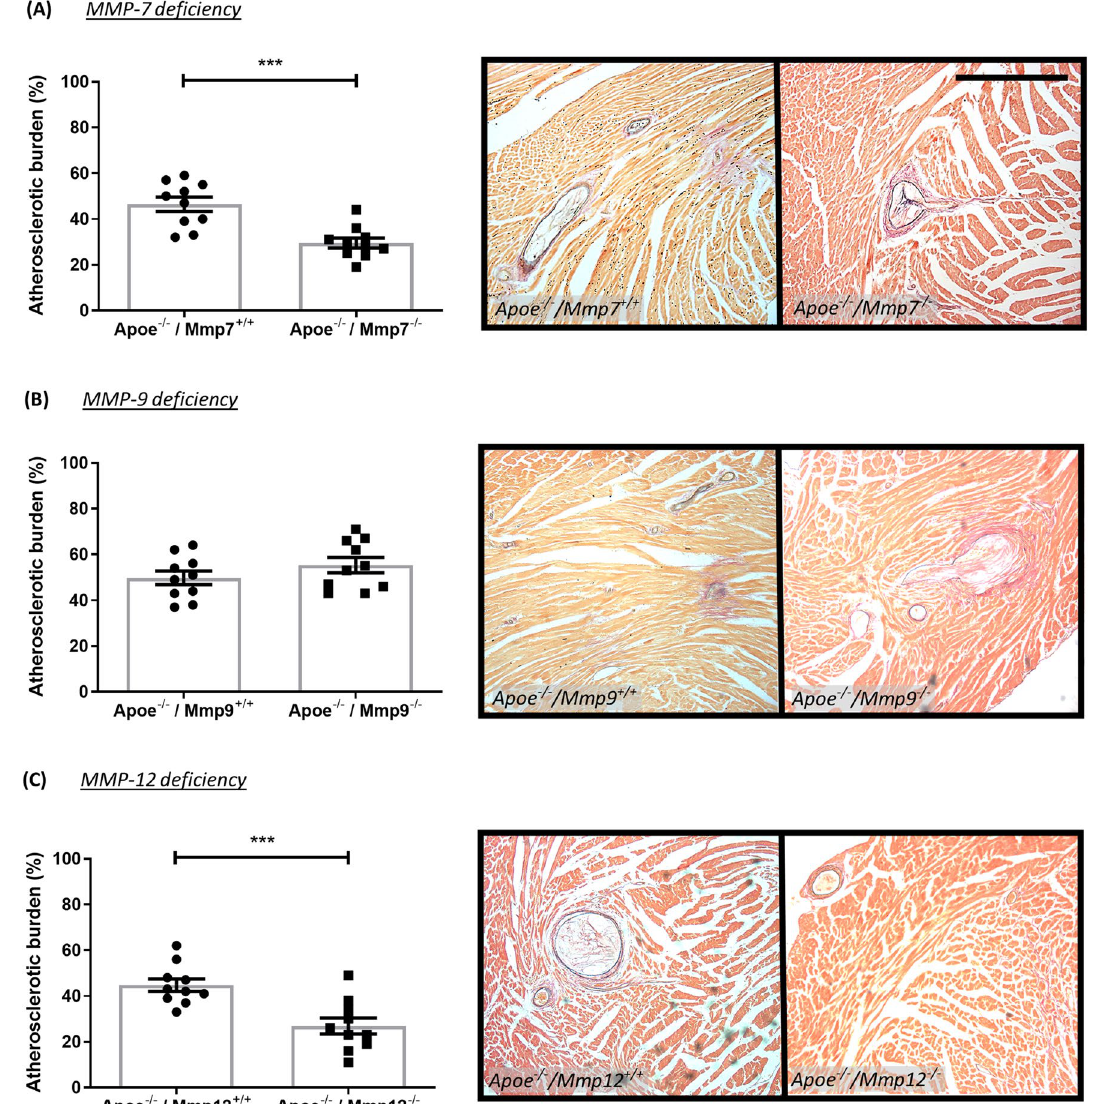
Figure 3. Effect of MMP modulation on coronary artery atherosclerosis in apolipoprotein E-deficient (Apoe -/- ) mice. Quantification and representative images of coronary atherosclerotic burden as assessed in EVG-stained hearts from 36-week high-fat fed Apoe -/- mice deficient for ( A ) MMP-7, ( B ) MMP-9, and ( C ) MMP-12, in comparison to their respective Apoe single knockout controls. Atherosclerotic burden (%) is presented as average plaque burden/coronary artery/mouse. Statistical significance is reported as *** P < 0.001 using unpaired Students t-test. Scale bar represents 1 mm and is applicable to all panels. In all cases, n = associated cardiac fibrosis/remodelling, suggesting that different MMPs/TIMPs can have opposing roles and act beneficially or detrimentally during atherosclerosis and post-MI remodelling. Such divergency may underly the observed ineffectiveness of broad spectrum MMP inhibition on both pathologies. In line with numerous murine experimental findings and human clinical trials, which demonstrated no beneficial effects of broad-spectrum MMP inhibition on atherosclerotic plaque formation and progression 24 , or adverse post-MI remodelling and subsequent heart failure prevention 25 , long-term or delayed administration of a non-selective MMP inhibitor (RS-130830) failed to exert beneficial changes in high-fat fed Apoe −/− mice. Moreover, in studies where ben- eficial effects of non-selective MMP inhibition on cardiac function and remodelling were observed, opposing deleterious actions were reported when the inhibitors were administered at different stages of disease (pre- or post-MI) or time of follow-up 25,26 . As such, identifying appropriate select culprit MMPs for therapeutic targeting may provide efficacious alongside ascertaining the most effective therapeutic window to avoid adverse events. MMP-7. We demonstrate that Apoe/MMP-7 double knockout mice presented with reduced atherosclerotic burden and increased cardiac fibrosis, alongside a heightened incidence of sudden death after 36-weeks of high- fat feeding, suggesting that MMP-7 has an adverse role in atherosclerosis, whereas, after an MI, MMP-7 activity